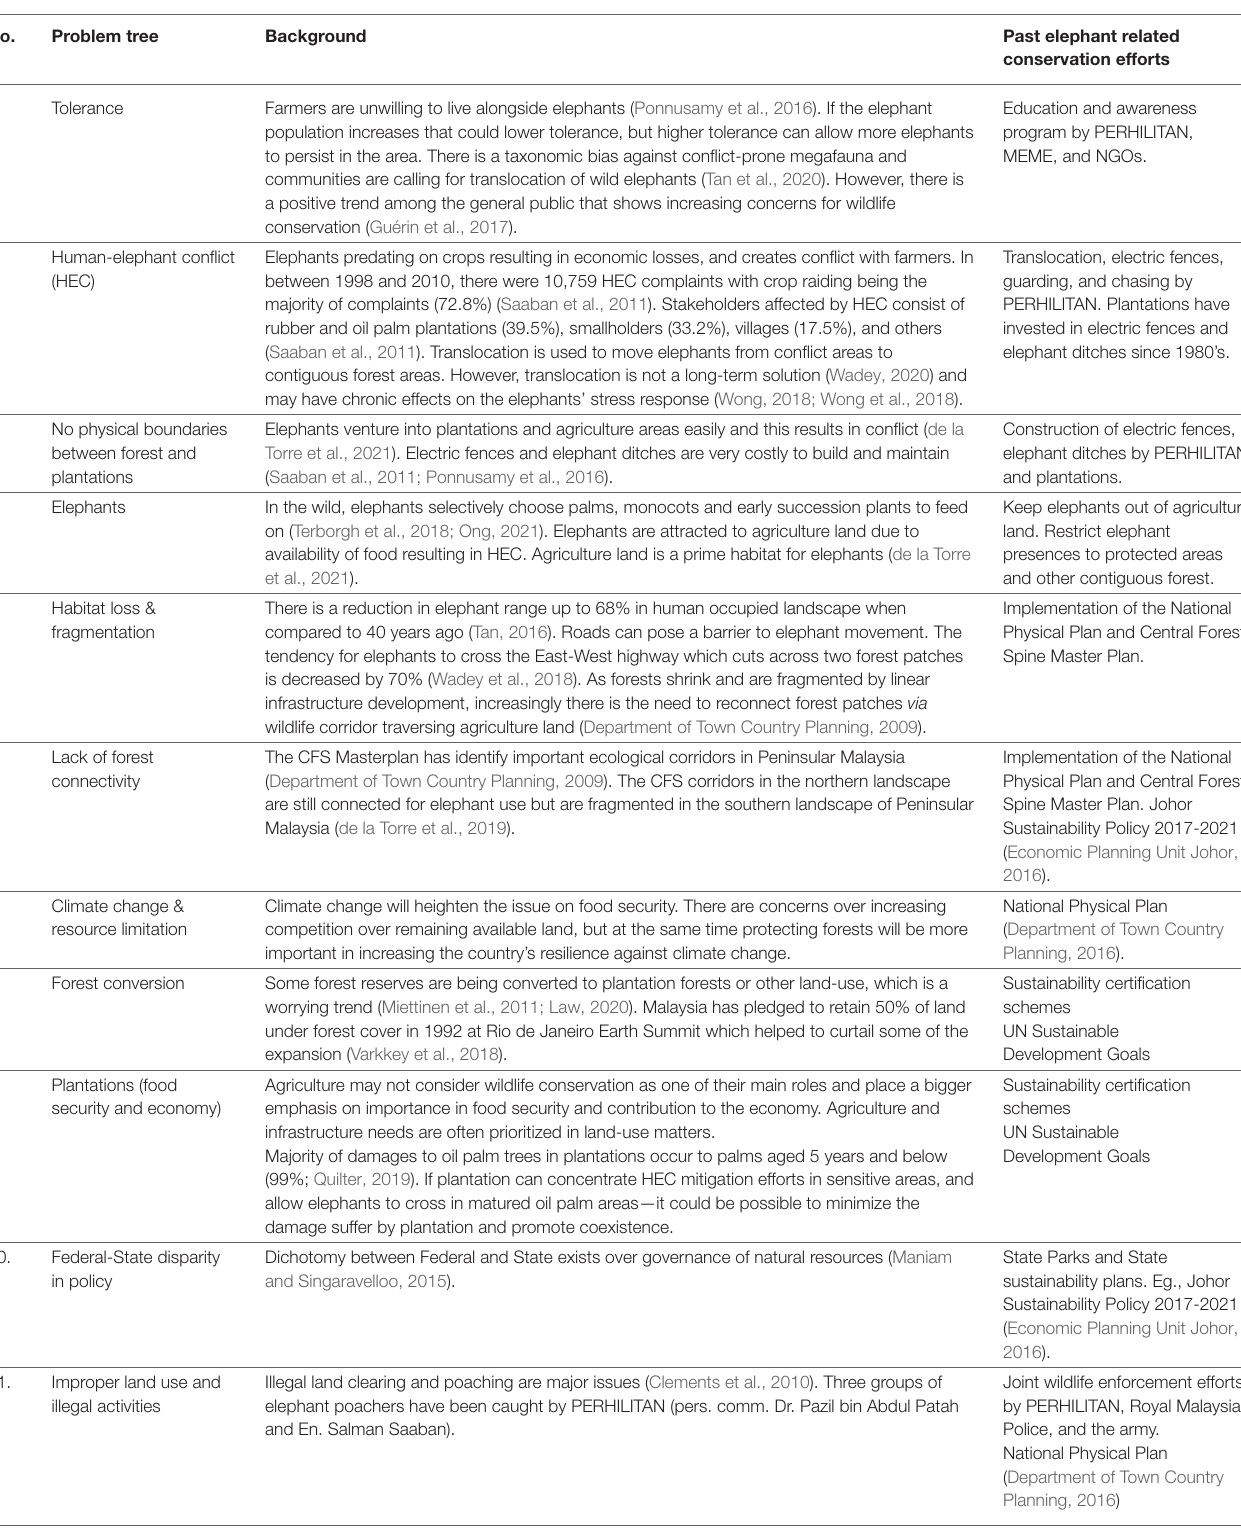
TABLE 1 | Background to the issues presented in the problem tree, with past conservation efforts in Malaysia.